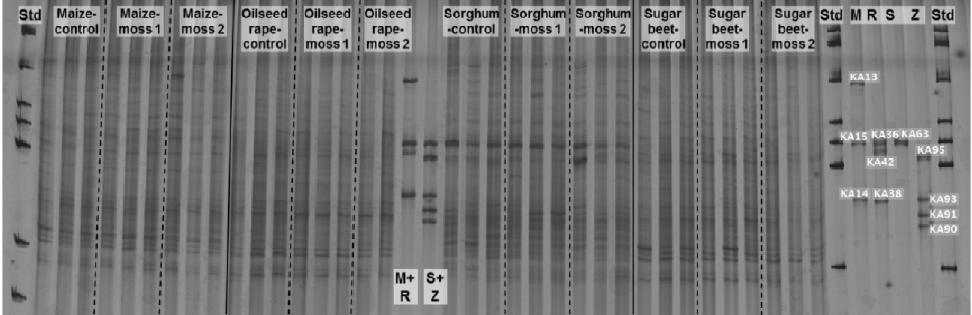
Figure 2. PCR-SSCP profiles of universal bacterial rhizosphere communities of moss-primed and untreated crop plants in two replicates (number) with three repetitions per plant species (three lanes per replicate). Legend: Std, standard 1 kb ladder for gel analysis. Internal marker: single bacterial isolates (right) and a mixture (middle) were sequenced and identified for the rhizosphere. Ladder maize (M): 1, Pseudomonas kilonensis KA13; 2, Pseudomonas brassicacearum subsp . brassicacearum KA15; 3, Arthrobacter nicotinovorans KA14. Ladder oilseed rape (R): 1, Pseudomonas brassicacearum subsp . brassicacearum KA36; 2, Pantoea